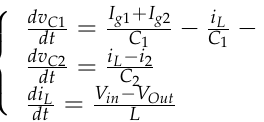
The state equation of mode 2 can be obtained from Figure